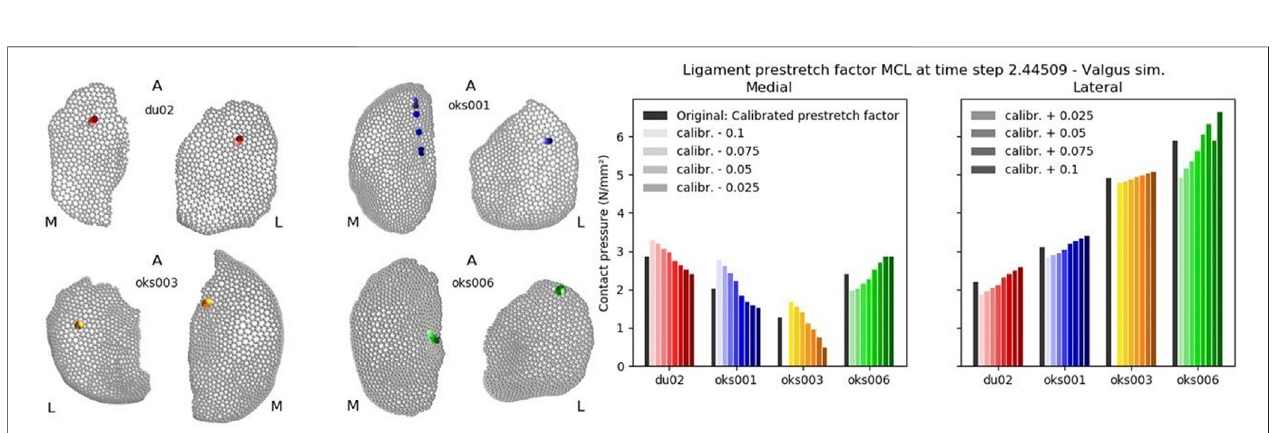
FIGURE 5 | Peak contact pressure location (left) and peak contact pressure (right) results for all valgus simulations of the Ligament prestretch factor MCL